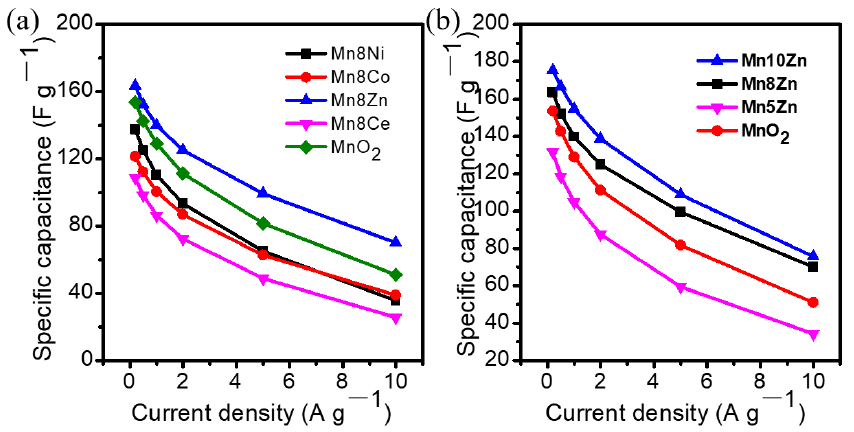
Figure 5. ( a , b ) The specific performance of the layered MO x - δ -MnO 2 (M = Co, Ni, Zn, Ce) materials at different current densities.